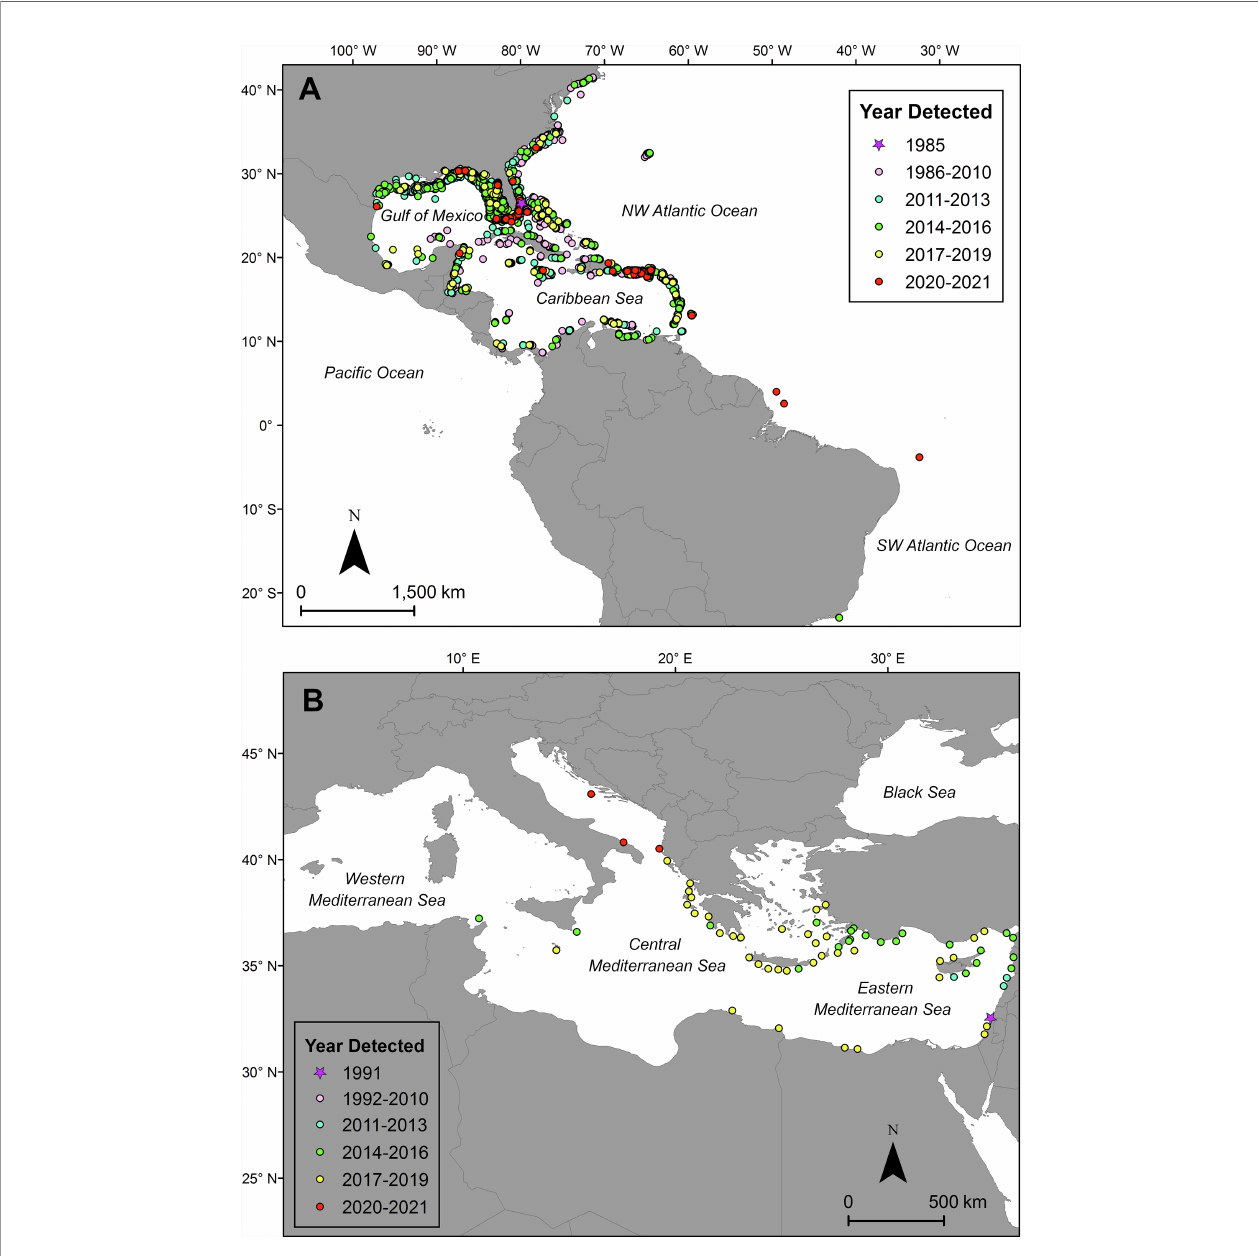
FIGURE 1 | Recorded sightings and chronology documenting the expansion of non-native lion fi sh ( Pterios volitans and P. miles ) in the (A) Western Atlantic Ocean and (B) Mediterranean Sea to